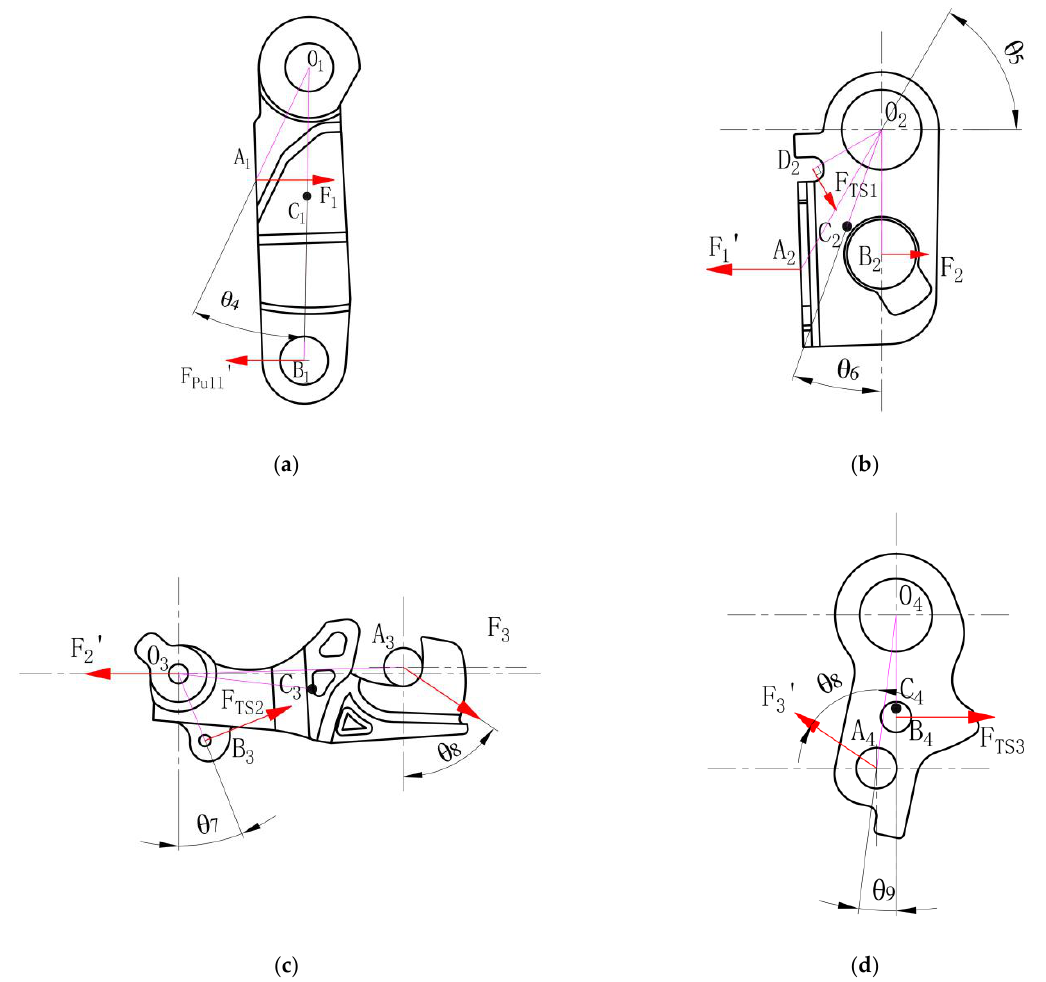
Figure 10. The schematic diagram of the force of the parts of the outside opening kinematic chain of the latch. ( a ) Outside opening toggle arm, ( b ) opening connect arm, ( c ) pawl connect arm, ( d ) pawl. Table 5. Size parameters of outside opening kinematic chain parts.